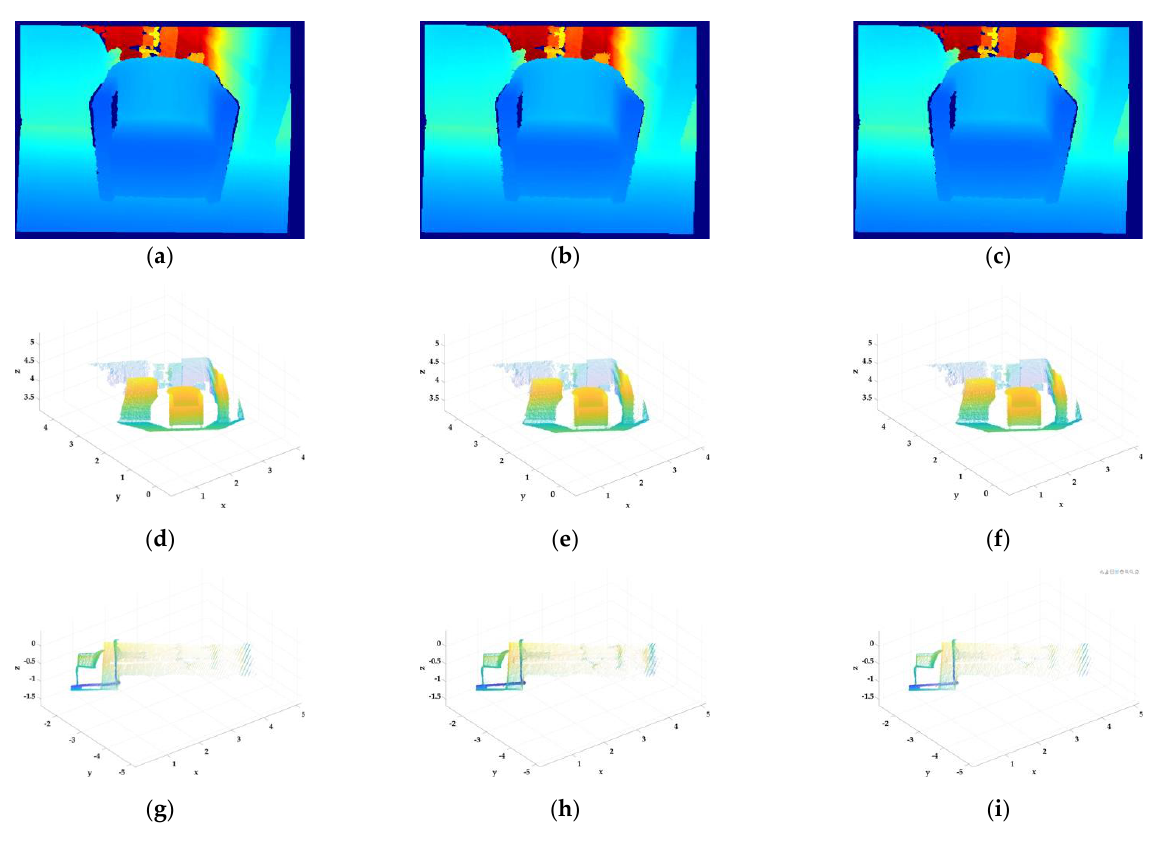
Figure 11. Validation of fractional−order differential Kriging interpolation super−resolution model (dataset no. 00333). ( a, d, g ) Original depth images; ( b, e, h ) Outputs of fractional−order differential Kriging interpolation super−resolution model ( 𝜈 = 0.6, PSNR = 33.299 dB); ( c, f, i ) Outputs of nearest- neighbour interpolation super−resolution model (PSNR = 29.795 dB). Table 3. super−resolution results of the method based on fractional−order differential Kriging inter- polation (400% up-sampling) and the nearest-neighbour interpolation method.